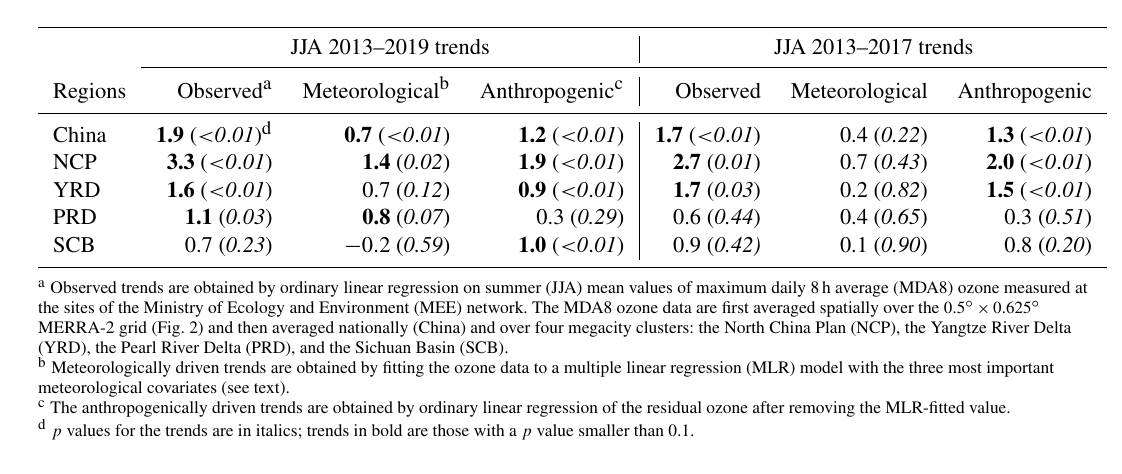
Figure 2. Summertime ozone trends in China from 2013 to 2019. Panel (a) shows the observed trends of summer mean MDA8 ozone at MEE sites averaged on the 0 . 5 ◦ × 0 . 625 ◦ ( ≈ 50 × 50km 2 ) MERRA-2 grid. The trends are obtained by ordinary linear regression and include sites with partial records. Panel (b) shows meteorologically driven trends determined by fitting ozone to meteorological covariates in the multiple linear regression (MLR) model. Panel (c) shows anthropogenic trends as inferred from the residual of the MLR model. Statistically significant trends above the 90% confidence level are marked with black dots. The mean trends for all of China and for the four megacity clusters (rectangles) are inset, where the regression is applied to the spatially averaged MDA8 ozone for the cluster. Numbers in bold are statistically significant above the 90% confidence level (Table 1). Table 1. The MDA8 ozone trends in China (ppba − 1 ) from 2013 to 2019 and from 2013 to 2017.